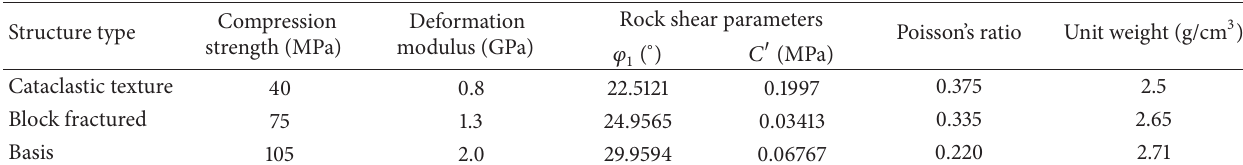
Table 5: Rock material parameters transferred from the DP3 to DP1